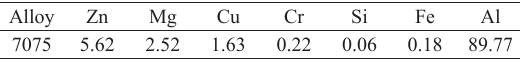
Figure 3. Experimental setup. Table 1. Elemental composition of AA7075.